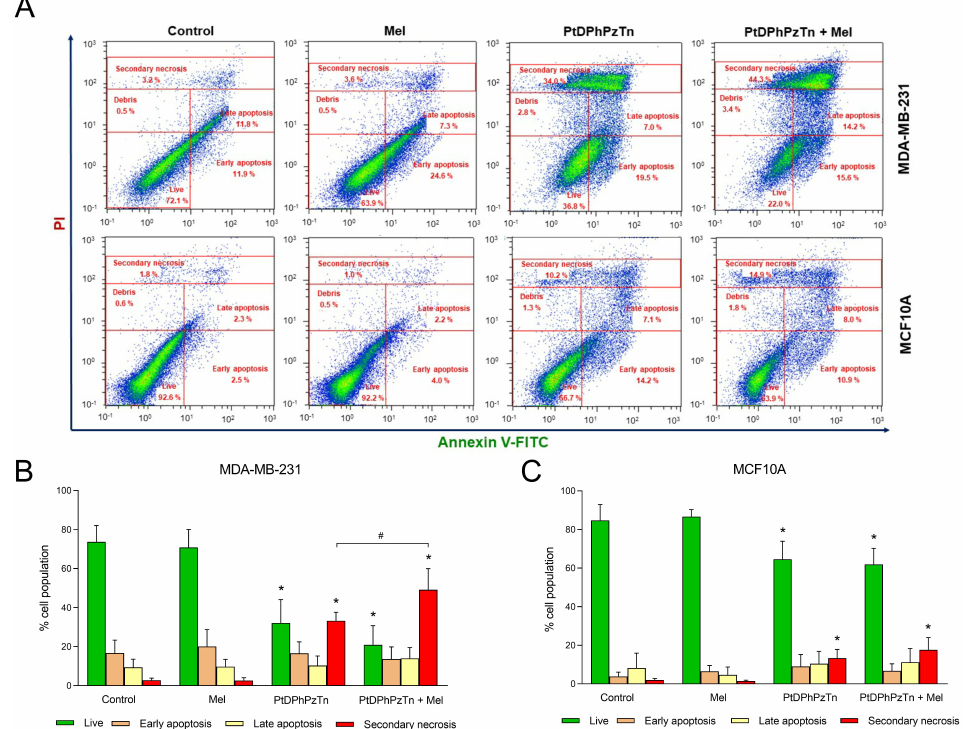
Figure 2. Combinatory treatment of PtDPhPzTn and melatonin differentially affects apoptosis of MDA-MB-231 and MCF10A cell lines. Cells were treated with 10.4 µ M PtDPhPzTn in the presence or absence of 1 mM melatonin (Mel), or the vehicle (DMF/DMSO, control) for 24 h. ( A ) Representative cytograms depicting the redistribution of phosphatidylserine (annexin V-FITC staining) in the presence of propidium iodide (PI) after challenging cells with the indicated drugs. Histogram bars show percentages of live, early apoptotic, late apoptotic, and secondary necrotic MDA-MB-231 ( B ) and MCF10A ( C ) cells. Values represent means ± S.D. of 5 independent experiments. * p < 0.05 compared to control values (Dunnett’s test). # p < 0.05 compared to PtDPhPzTn-treated cells (Tukey’s test). On the other hand, the complex PtDPhPzTn turned out to be less harmful to MCF-10A human breast epithelial cells than to tumor cells, as the very same dose of PtDPhPzTn (10.4 µ M) only provoked a moderate reduction in the proportion of live cells (64.58 ± 9.31% vs. 84.76 ± 8.14%; p < 0.05; Figure 2A,C) with respect to control cells. Other